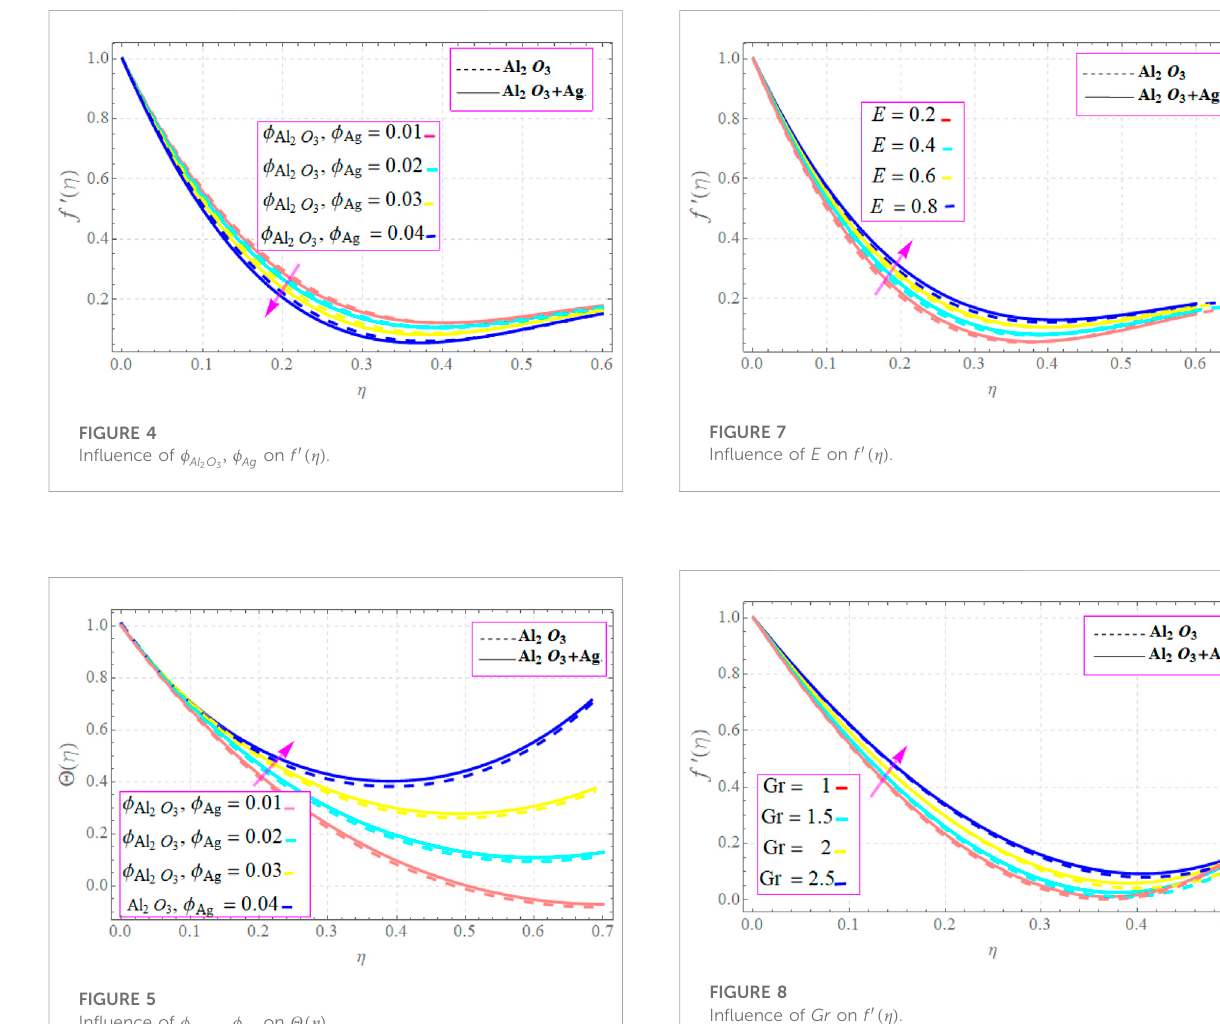
, ϕ Ag on Θ ( η ) . 2 O 3